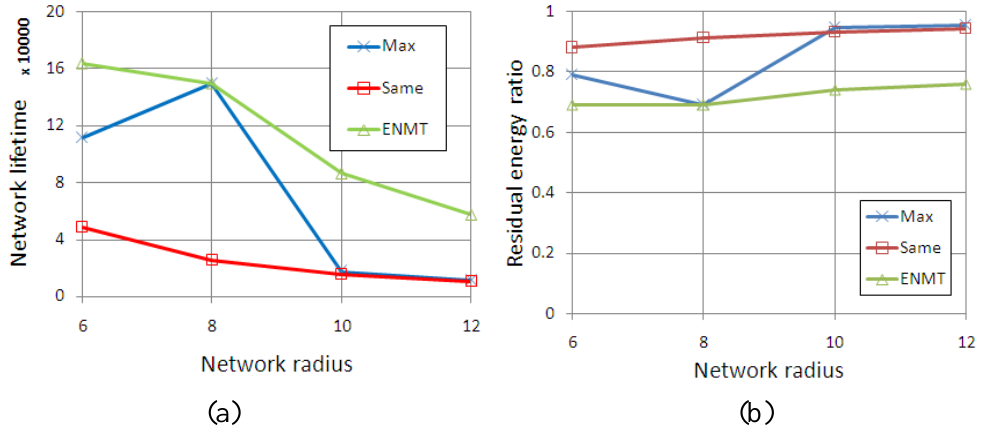
Figure 7. Simulation results (4 and 2). (a) Network Lifetime. (b) Residual energy ratio.